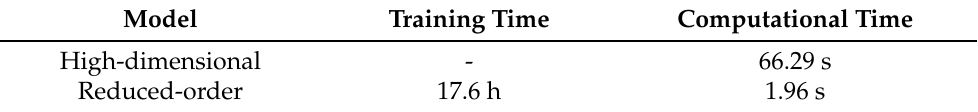
Table 3. Computation time for high-dimensional and reduced-order